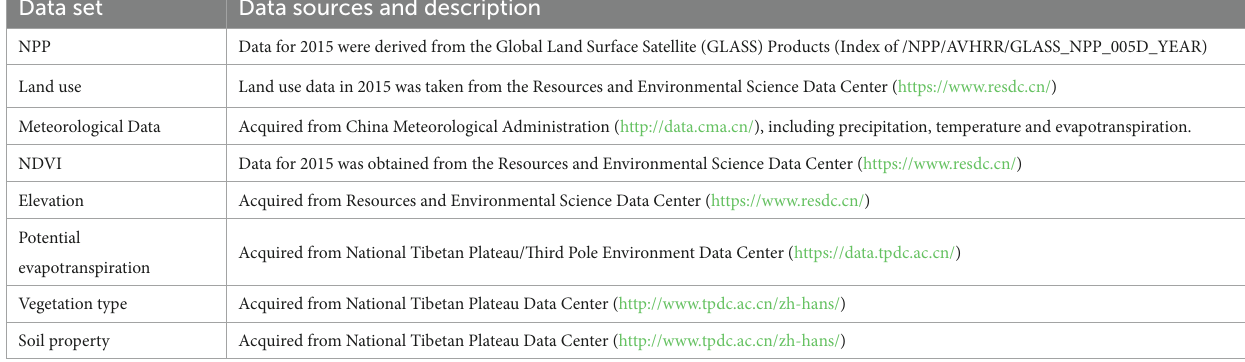
TABLE 1 Data sources for ecosystem services